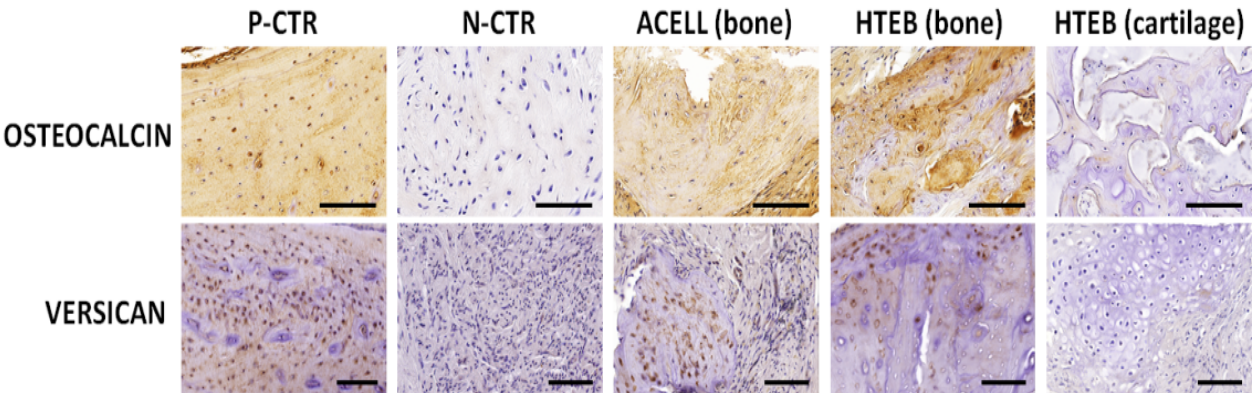
Figure 6. Analysis of ECM components at the defect area of each group of animals included in the study, as determined by immunohistochemistry for osteocalcin and versican. P-CTR: native normal animals, used as positive controls; N-CTR: animals subjected to surgical removal of a fragment of the right mandible, used as negative controls; ACELL: animals subjected to surgical removal of a fragment of the right mandible and implant of a nanostructured fibrin-agarose biomaterial; HTEB: animals subjected to surgical removal of a fragment of the right mandible and implant of a nanostructured human tissue-engineered bone substitute. Scale bars: 100 µ